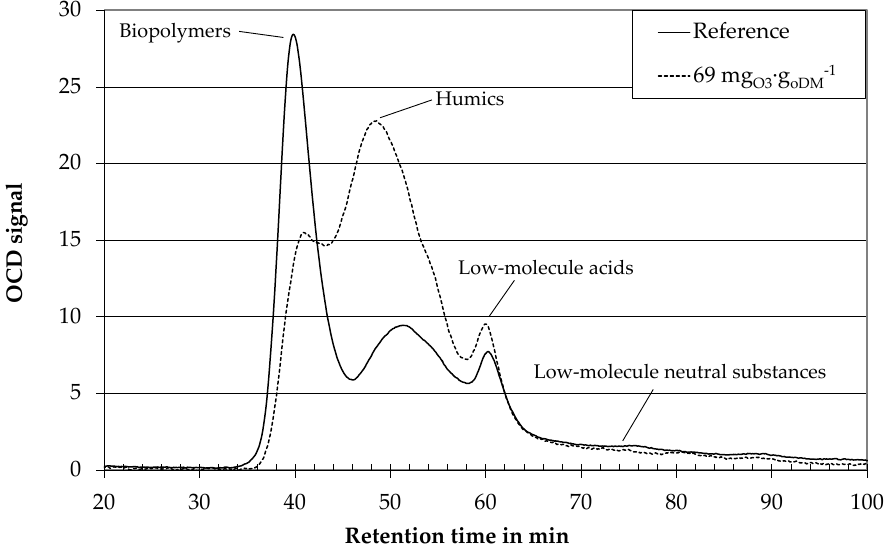
Figure 4. LC OCD analyses of digestate centrate of an agricultural biogas plant with ozone treatment and without. Dilution 1:400.